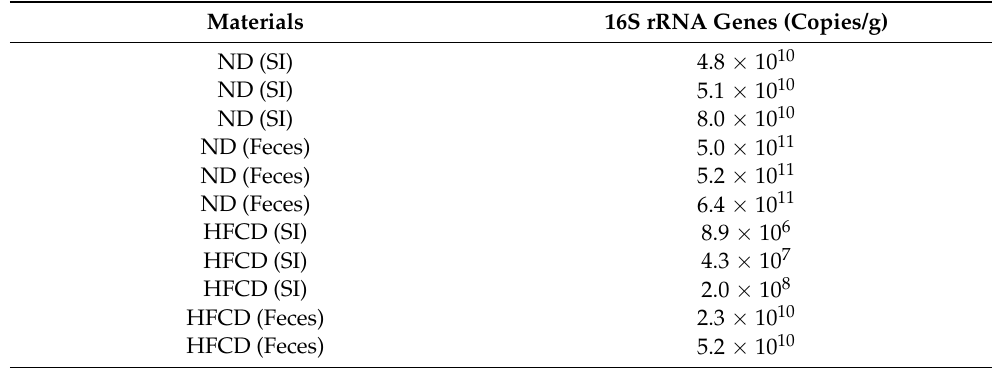
Table 1. Quantitative analysis of 16S rRNA genes of bacteria of small intestine (SI) and feces in stroke-prone spontaneously hypertensive-5 (SHRSP5) rats fed normal diet (ND) or high-fat- and high-cholesterol-containing diet (HFCD) by real-time PCR.